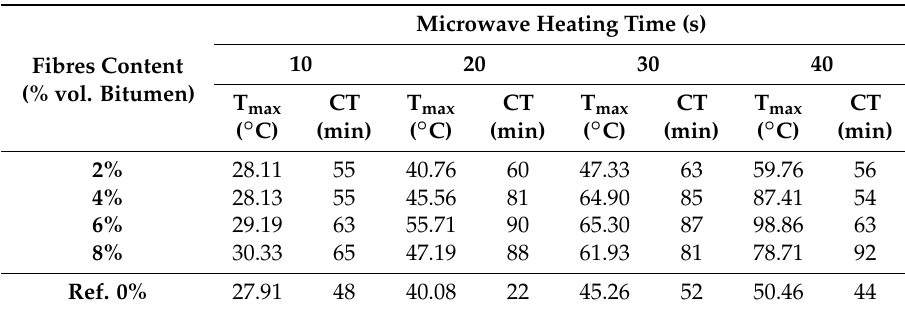
Table 2. Average results of the heating-cooling test on asphalt